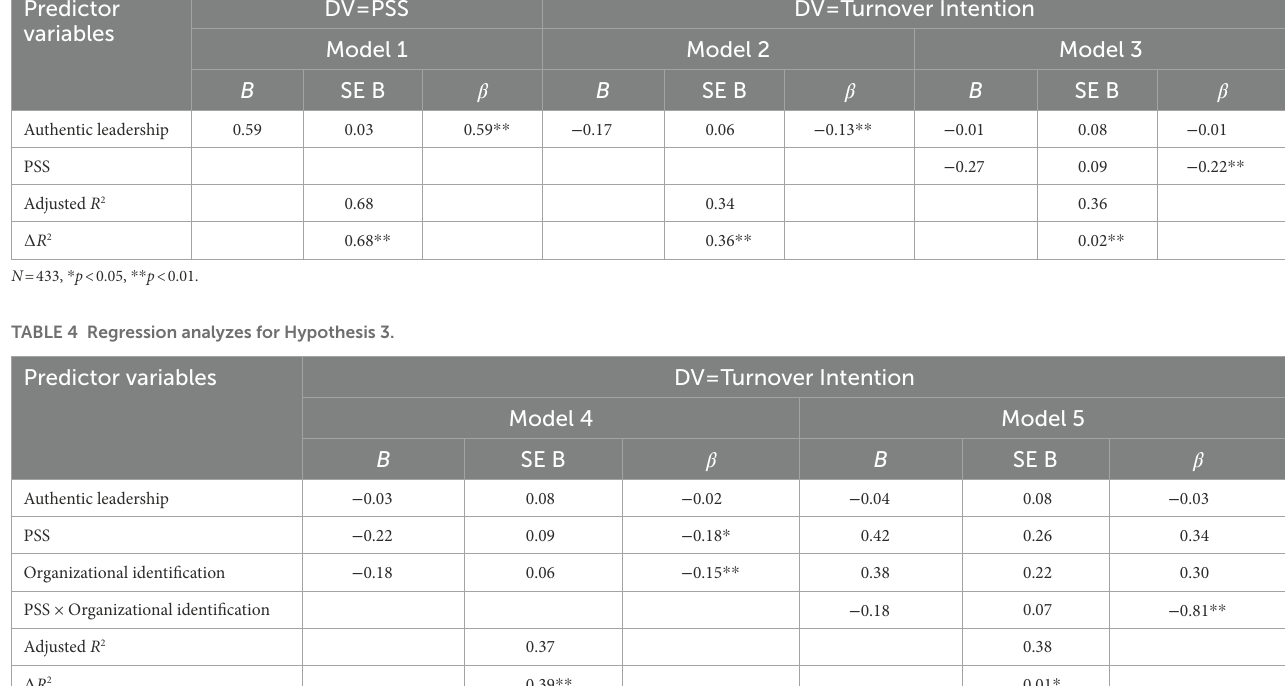
TABLE 3 Regression analyzes for Hypotheses 1 and 2. Predictor variables